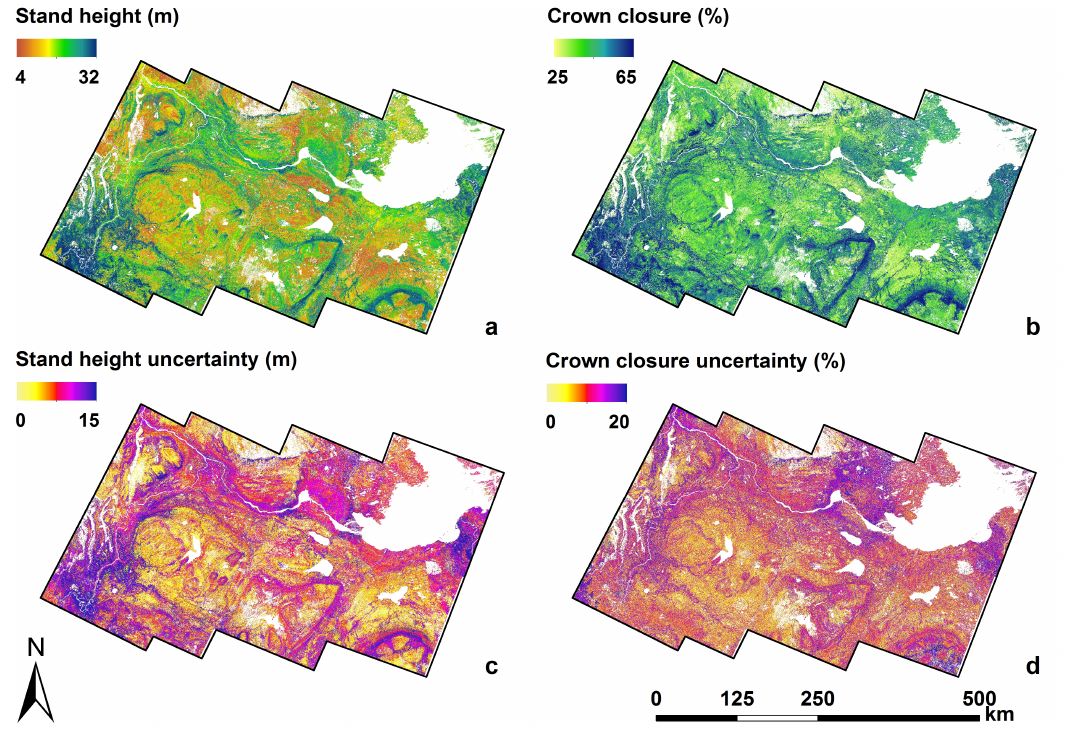
Figure 5. k-NN mapped ( a ) stand height and ( b ) crown closure, and associated uncertainties mapped for ( c ) stand height, and ( d ) crown closure. Non-forested features appear as